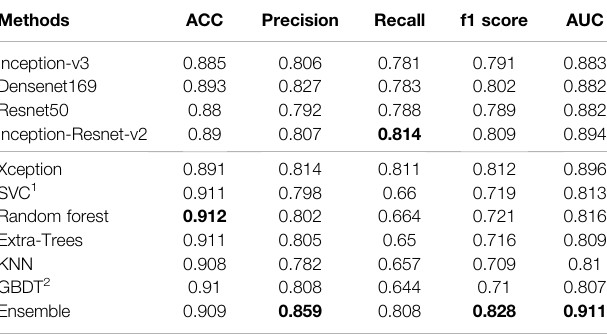
TABLE 5 | Average results of two skin lesion classi fi cations of different networks.